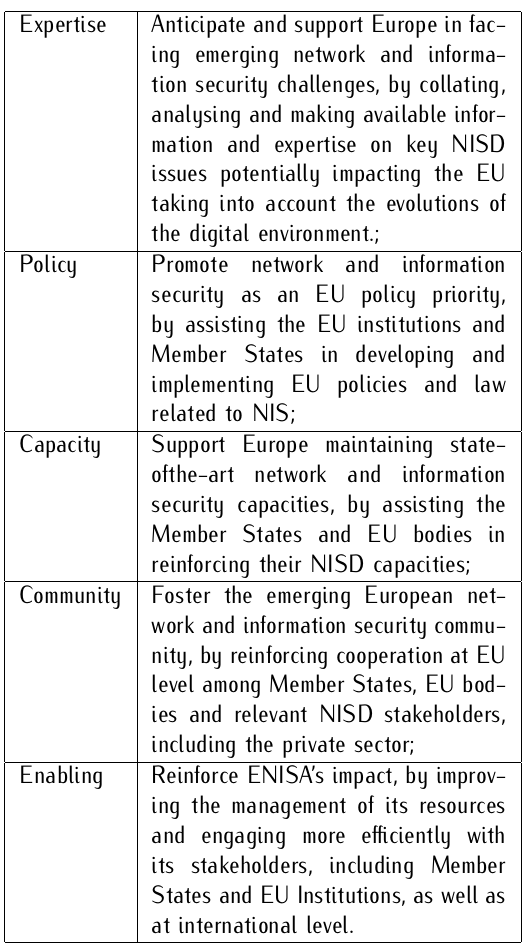
Table 1. ENISA Strategy